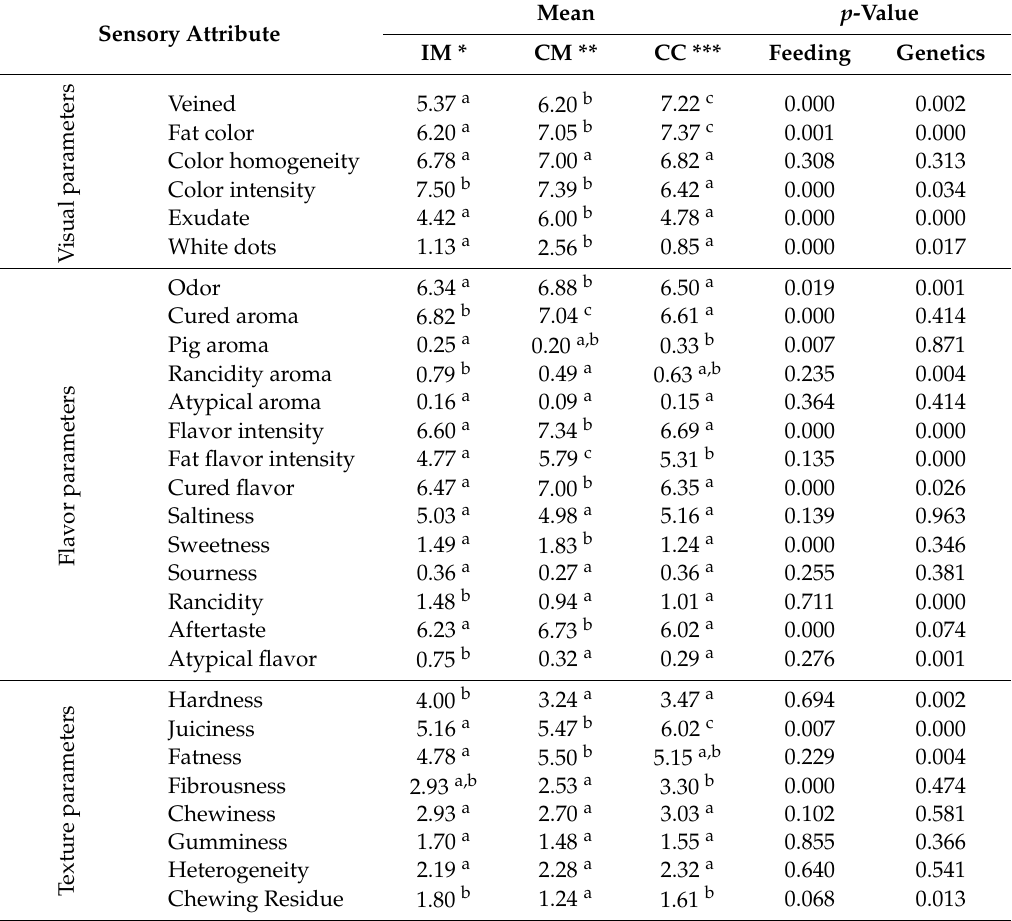
Table 2. Scores for each sensory attribute of dry-cured ham determined by the sensory panel and results of the statistical analysis of the influence of the feeding and the genetics of the animals.